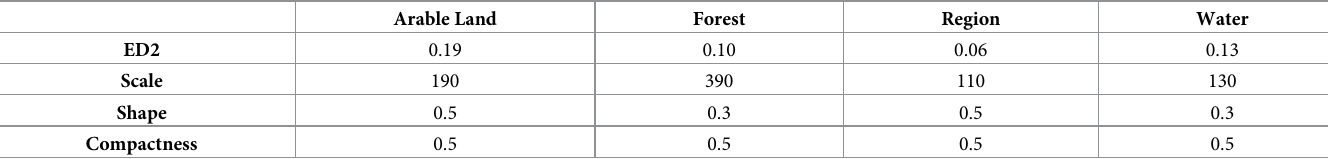
Table 2. Optimal segmentation parameters of background elements for each development area.